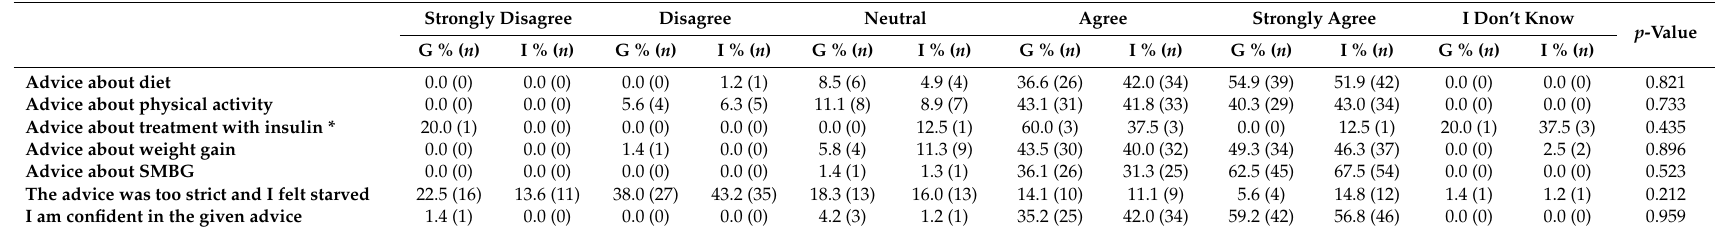
Table 7. Agreement with the feasibility of the advice for the management of